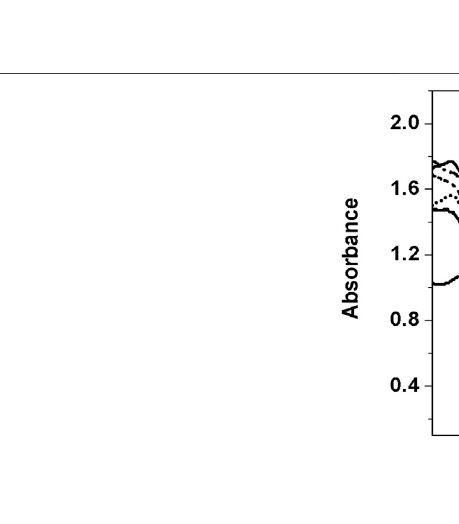
Frontiers in Chemistry |